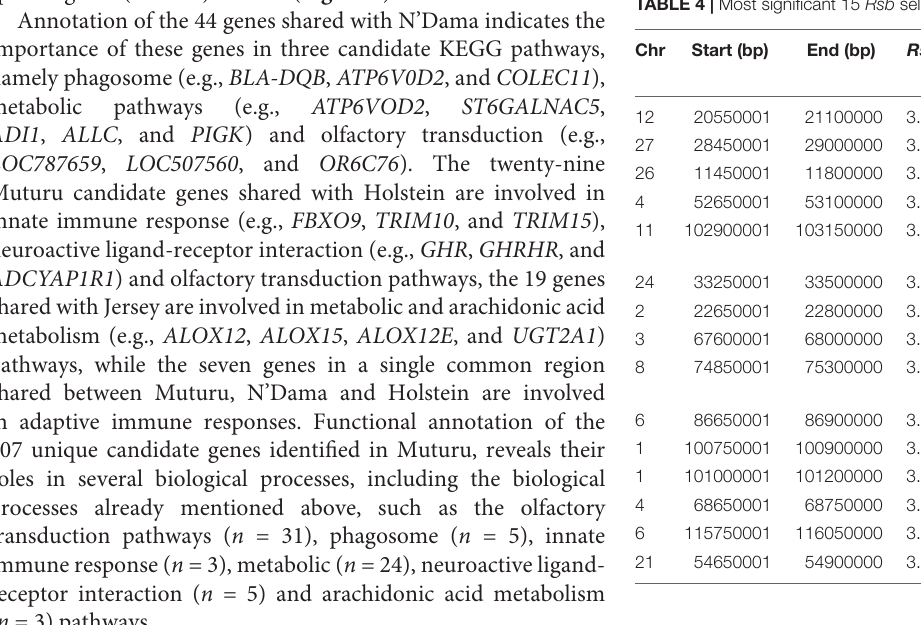
TABLE 4 | Most significant 15 Rsb selection signatures regions in